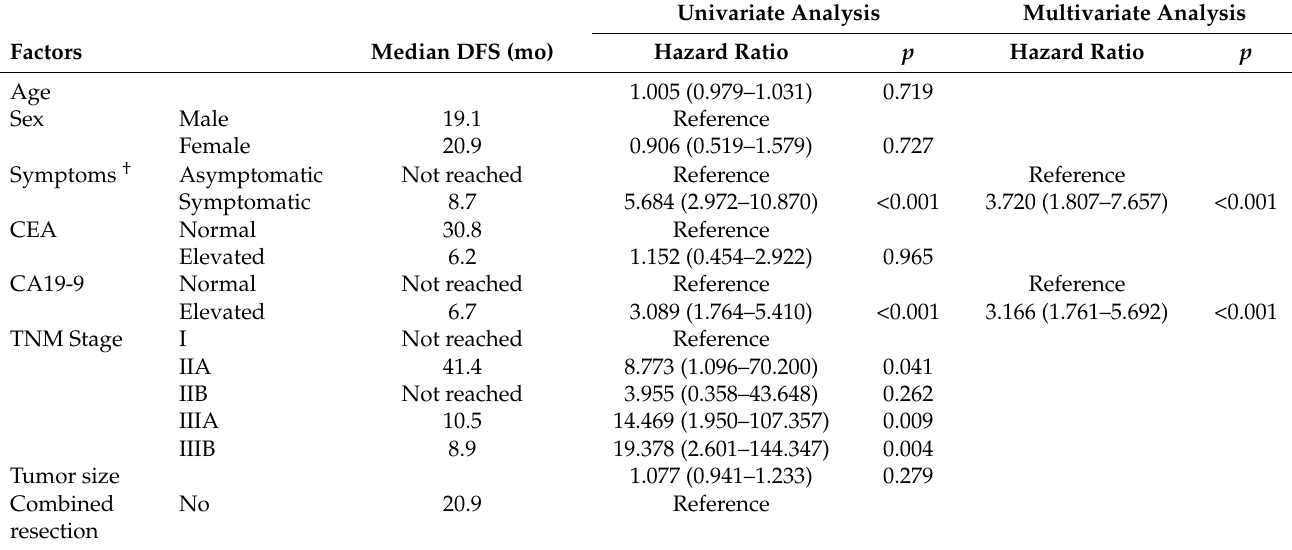
Table 4. Uni- and multivariate analysis identifying factors affecting patients’ recurrence ( n = 109). Univariate